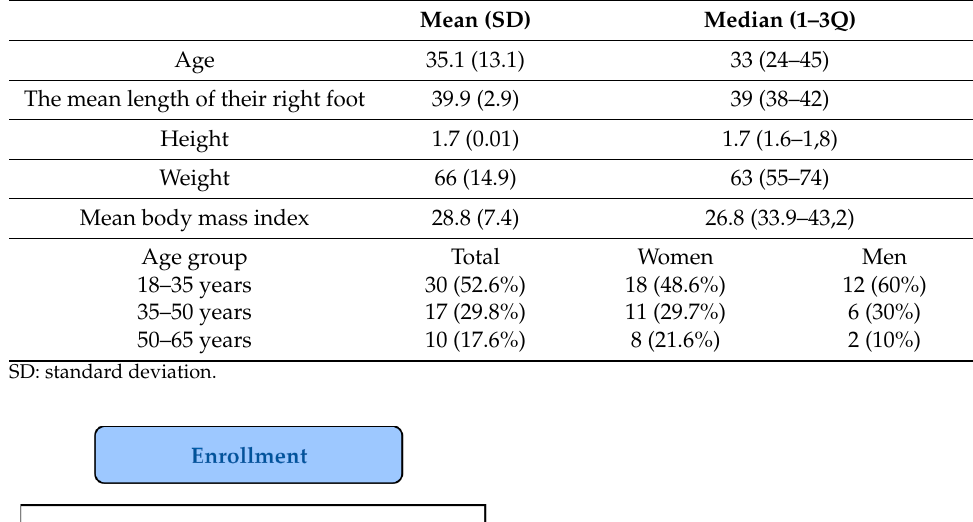
Table 1. Summary of individual’s characteristics.